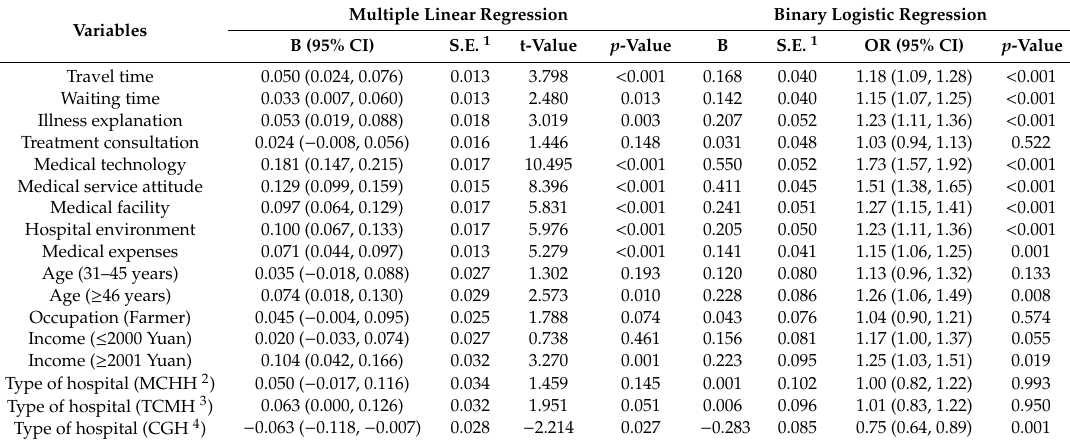
Table 4. Multiple linear regression and binary logistic regression analyses on determinants of the outpatients’ overall satisfaction with rural medical services. Multiple Linear Variables